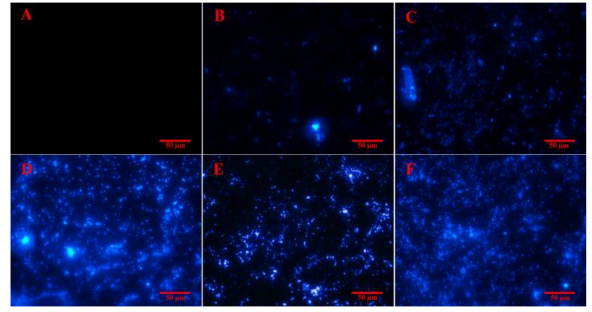
Figure 4. The epifluorescence microscopy (EFM) images of cells of S. metallicus adsorbed on the surface of untreated chalcopyrite: ( A ) day 0; ( B ) day 2; ( C ) day 4; ( D ) day 6; ( E ) day 8; ( F ) day